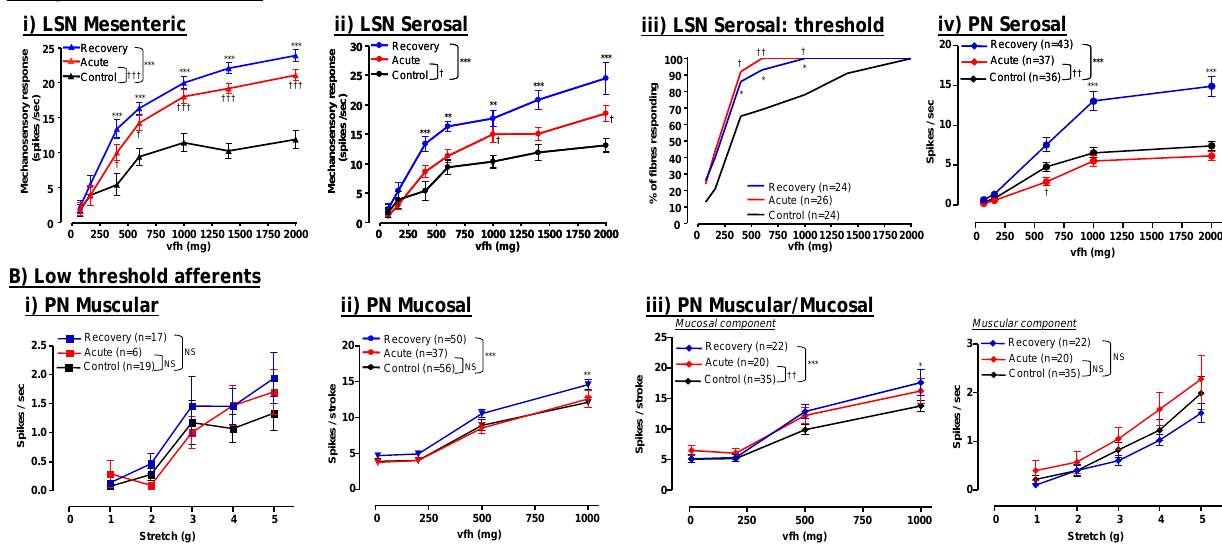
Figure 2. Specific classes of murine mechanosensitive colonic afferent become hypersensitive during and after inflammation. TNBS-induced colitis causes pronounced mechanical hypersensitivity in ( A ) high-threshold splanchnic (LSN): ( A i ) mesenteric afferents and ( A ii ) serosal afferents and ( A iii ) increases the percentage of afferents responding at a given stimulus intensity. These effects on mechanosensitivity become more apparent after resolution of inflammation (recovery; 30 days post-TNBS administration) when compared with acute conditions (7 days post-TNBS); ( A iv ) By contrast, pelvic (PN) high-threshold serosal afferents only become hypersensitivity following resolution from inflammation (recovery); ( B ) Low-threshold afferents display little or no change in mechanosensitivity after TNBS-induced colitis. Minor, but significant increases in mucosal responsiveness are observed in ( B ii ) mucosal and ( B iii ) muscular/mucosal afferents. By contrast, ( B i ) muscular and ( B iii ) muscular/mucosal afferent responses to stretch are unaffected by inflammation in the mouse. Modified from Hughes et al. , [37] with